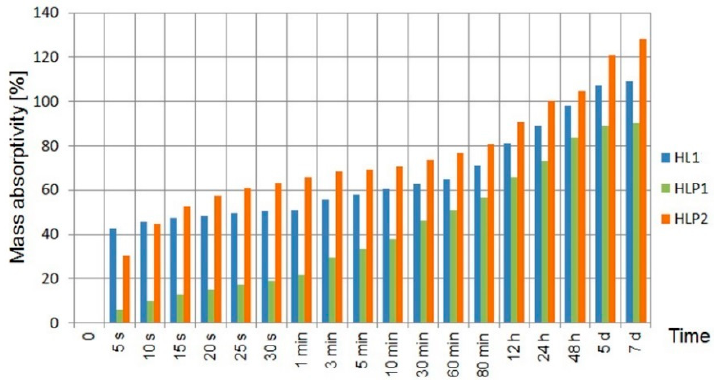
Figure 6. Mass absorptivity of composites.